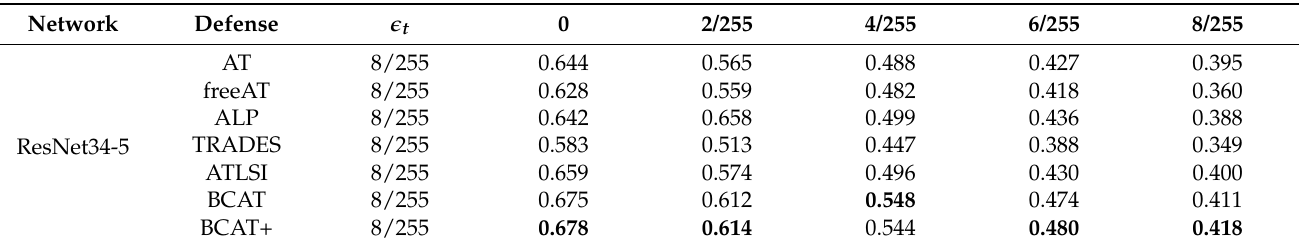
Table 2. Comparing the white-box adversarial robustness generalization accuracy of different defense methods on CIFAR-100.